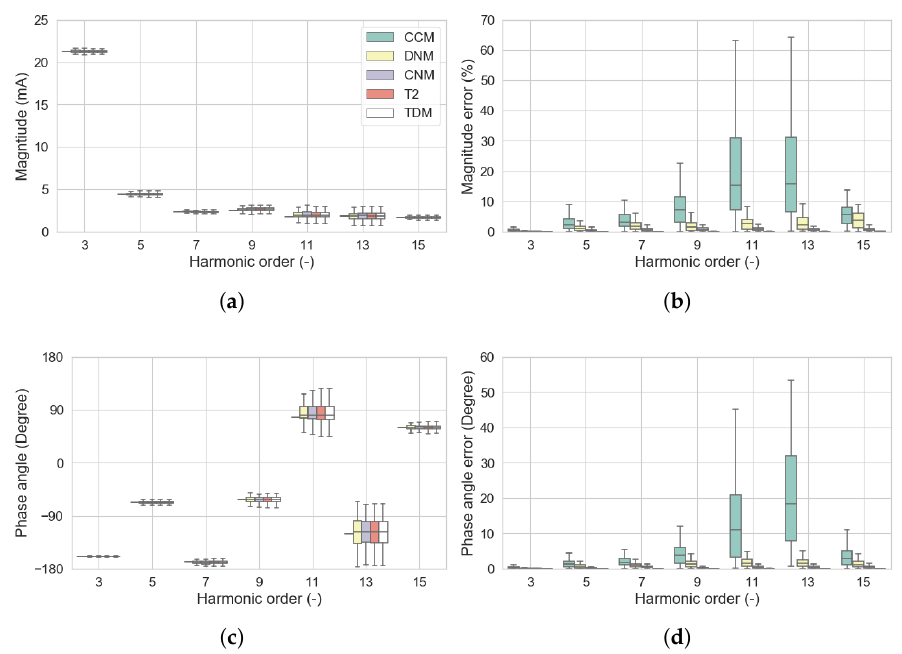
Figure 18. Comparison of the Type D LED lamp frequency domain models for flat-top voltage supply: ( a ) Magnitude; ( b ) Magnitude error; ( c ) Phase angle; and ( d ) Phase angle error.